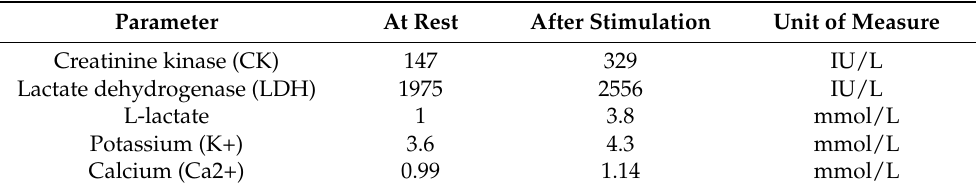
Table 1. Results of altered parameters of serum biochemical profiles of the affected calf at rest and after stimulation. Parameter At Rest After Stimulation Unit of Measure Creatinine kinase (CK) 147